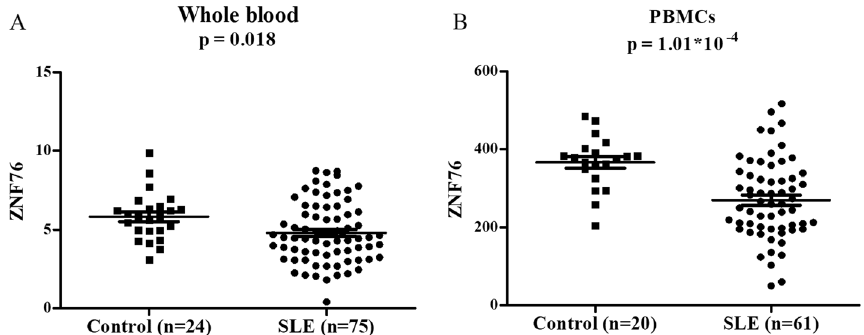
Figure 4. The mRNA expression of ZNF76 was decreased in SLE patients comparing with controls. The expression levels of ZNF76 were compared between SLE patients with healthy controls in our cohort shown as FPKM (Fragments Per Kilobase of transcript sequence per Millions base pairs sequenced) ( A ) and E-GEOD-50772 project shown as expression values ( B ). The differences of ZNF76 expression between SLE patients and healthy controls were calculated by Student’s t-test. Abbreviation: PBMC, peripheral blood mononuclear cells; FPKM, fragments per kilobase of transcript sequence per millions base pairs